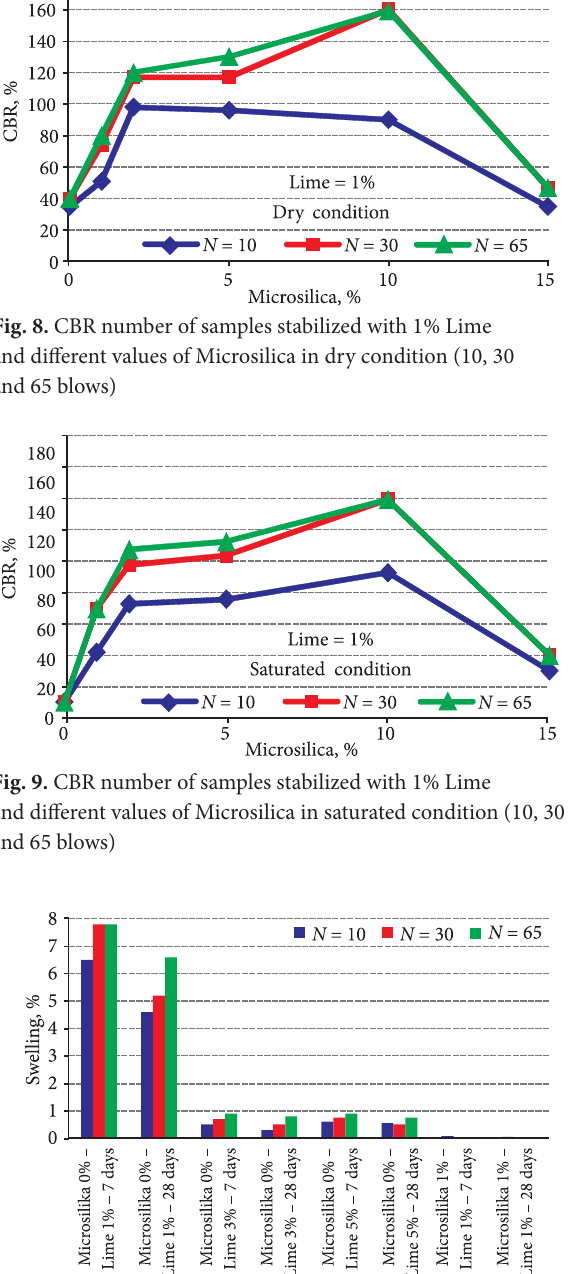
Fig. 10. Swelling potential of the samples stabilized with different percentages of